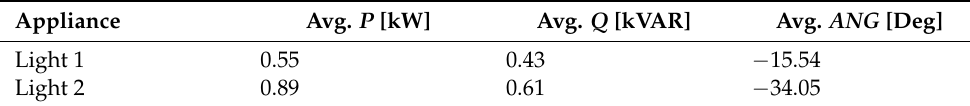
Table 2. Example: Features Estimation for Lights Appliances. Table 2. Power Estimation for Devices (AMPds Dataset). Appliance Avg. P [kW] Avg. Q [kVAR] Avg. ANG [Deg] Light 1